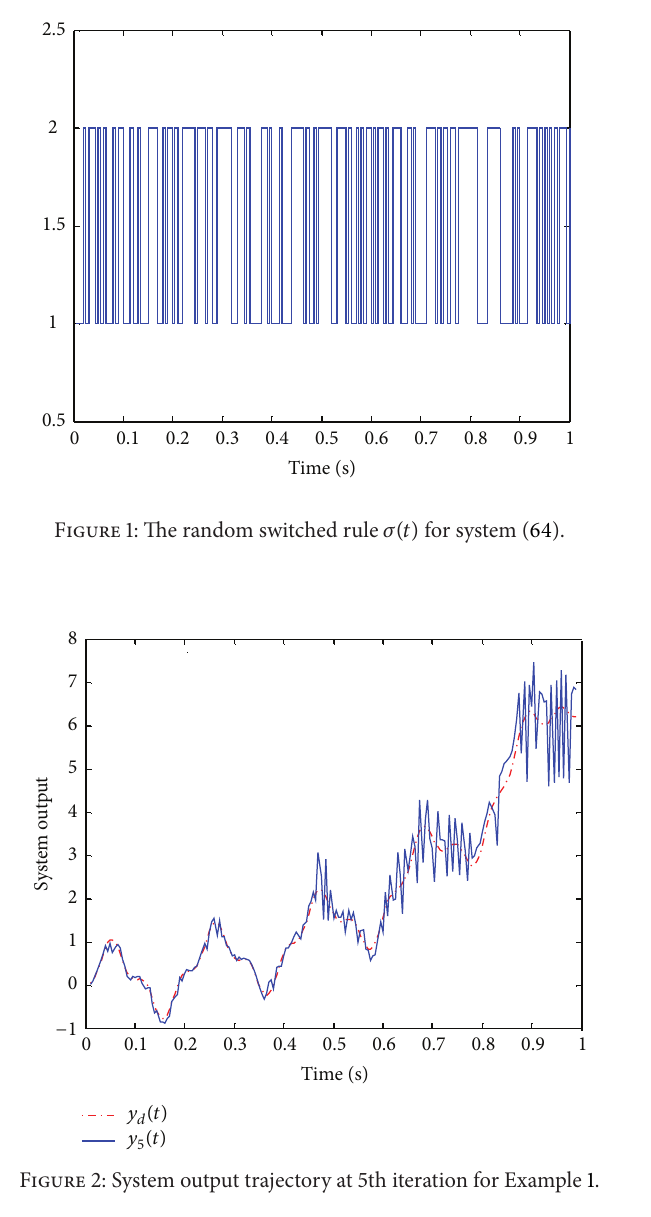
Figure 4: System output trajectory at 30th iteration for Example